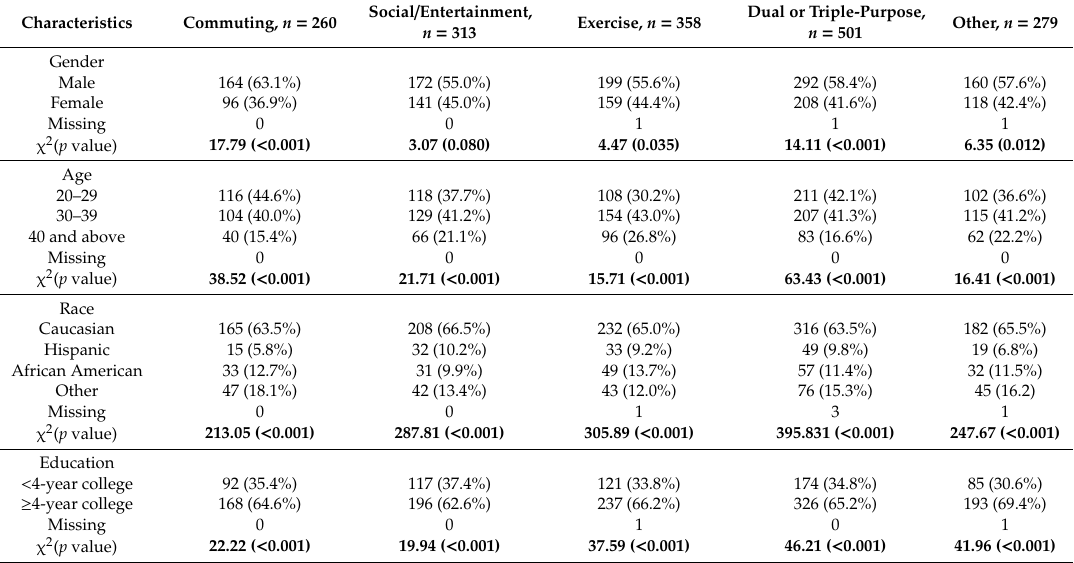
Table 1. Characteristics of participants by bike share trip purposes. Significant results are in